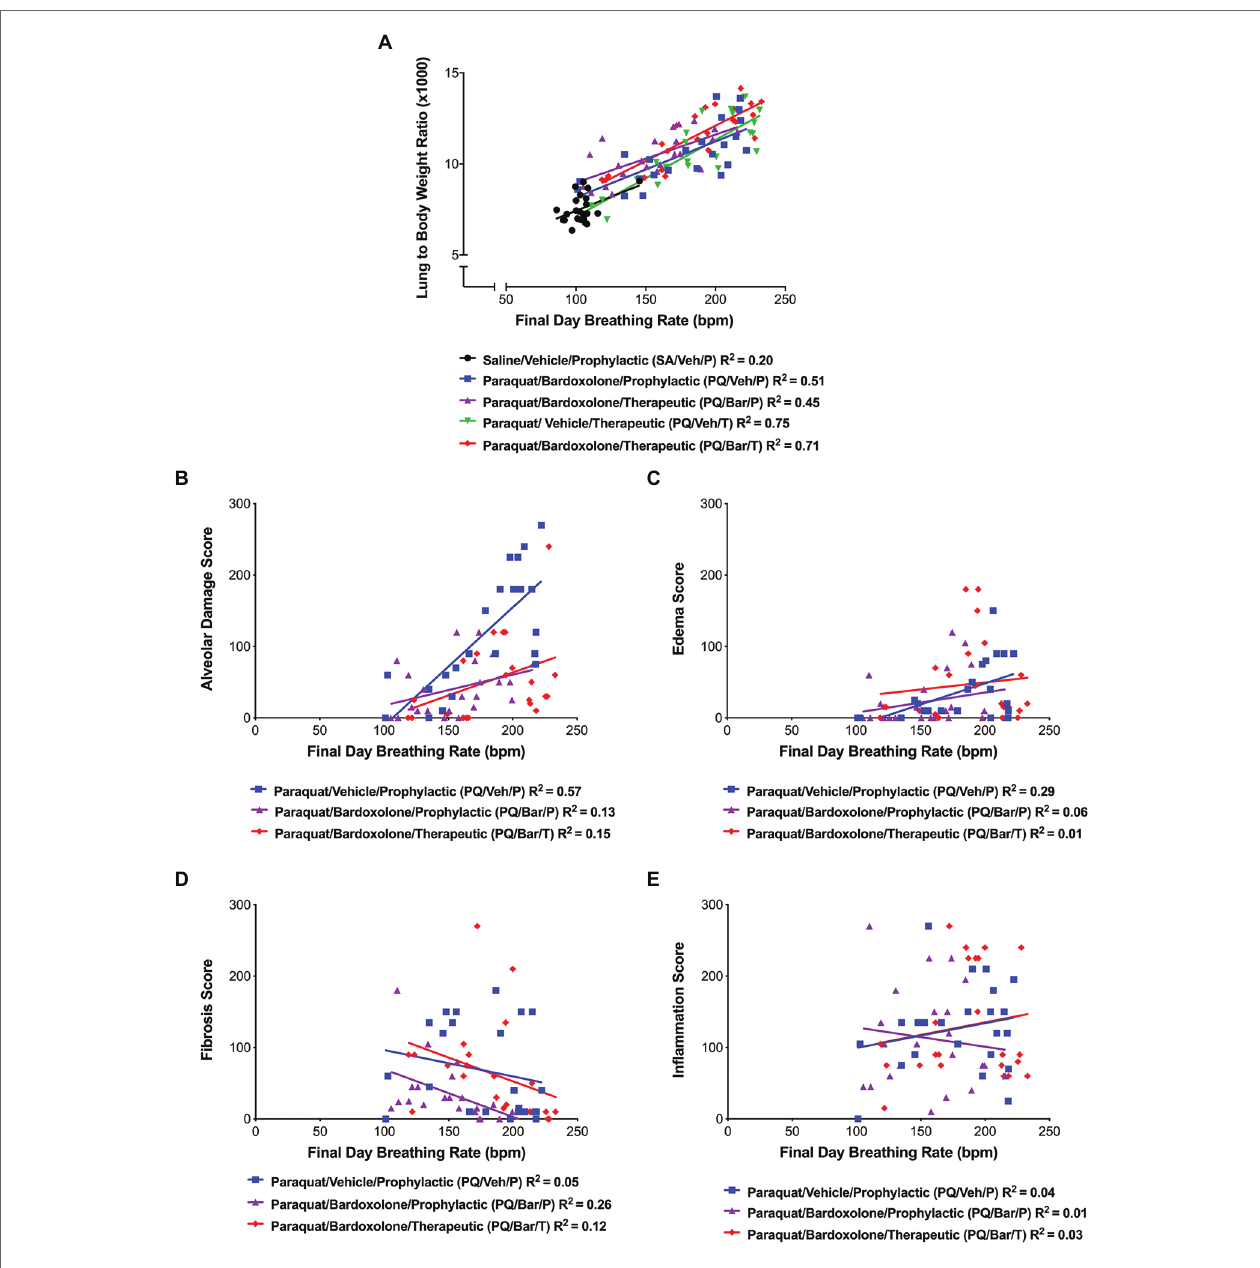
FIGURE 5 | Breathing rate correlated with normalized, endpoint lung weights and histopathology. (A) Lung weight to body weight ratios vs. breathing rate. Breathing rate positively correlated with normalized lung weights for all groups as follows: SA/Veh/P ( R = 0.45), PQ/Veh/P ( R = 0.71), PQ/Bar/P ( R = 67), PQ/Veh/T ( R = 0.87), and PQ/Bar/T ( R = 0.85); p ≤ 0.05. (B) Alveolar damage score vs. breathing rate. Breathing rate positively correlated with alveolar damage scores, specifically for rats administered PQ and treated with vehicle (PQ/Veh/P; R = 0.76, p ≤ 0.0001). (C) Edema score vs. breathing rate. Breathing rate positively correlated with edema scores, specifically for PQ/Veh/P rats ( R = 0.54, p ≤ 0.01). (D) Fibrosis score vs. breathing rate. Breathing rate negatively correlated with fibrosis scores, specifically for rats administered PQ and treated prophylactically with bardoxolone (PQ/Bar/P; R = − 0.51, p ≤ 0.05). (E) Inflammation score vs. breathing rate. There was no significant correlation between inflammation scores and breathing rate for all rats administered PQ in which histopathology quantification was performed. n = 22–24 rats per treatment